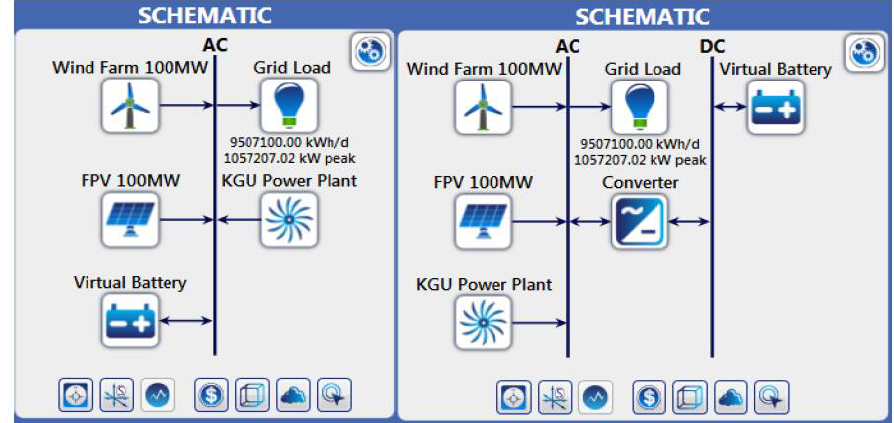
Figure 18. Graphic showing a hybrid energy system schematic in Homerpro.